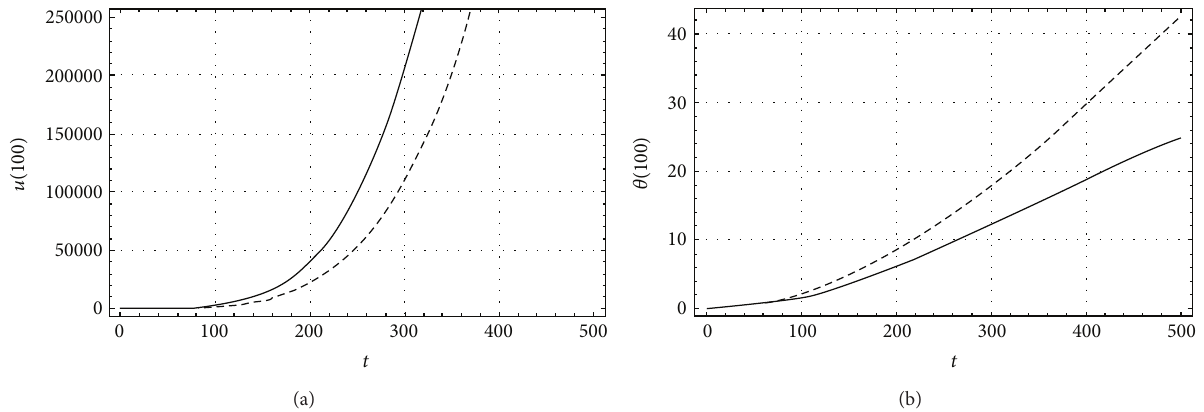
= 0.05 , 𝛾 = 1 , 𝛿 = 0.8 , 𝜏 2